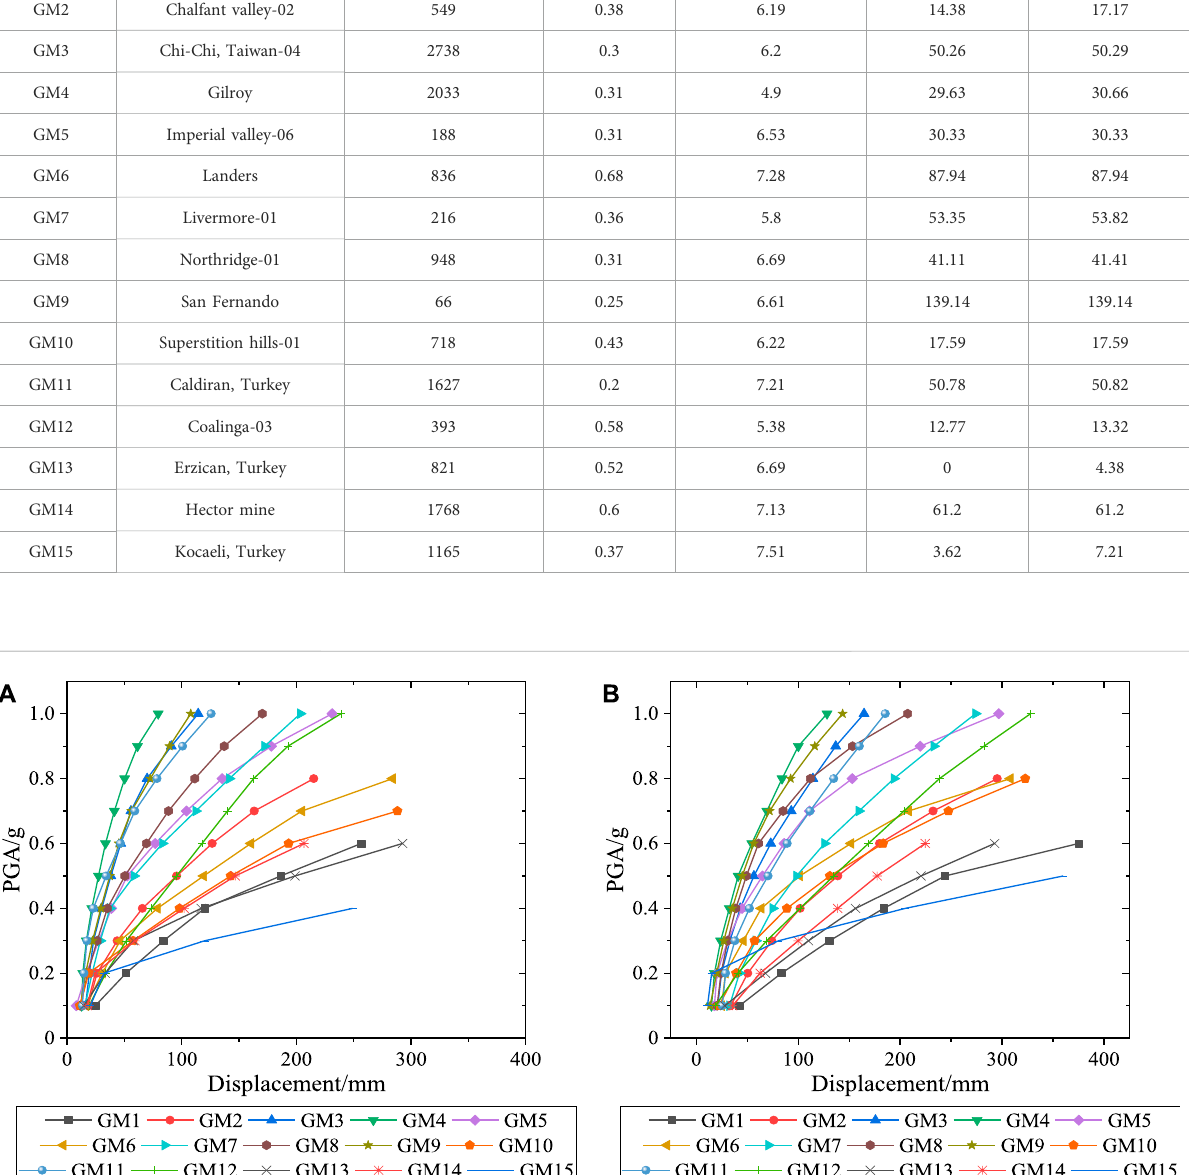
the vertical compressive stress limit of isolated bearing, and that the maximum compressive stress, 13.07 MPa, is located in the upper isolated layer. According to the IDA curves of the maximum vertical stress of the two isolated layers, the isolated bearings are consistently under pressure for the majority of